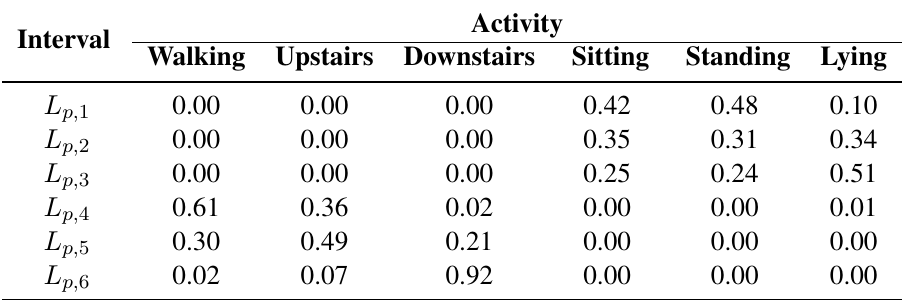
Table 6. Activity-interval matrix U for the standard deviation with 6 discretization intervals and 6